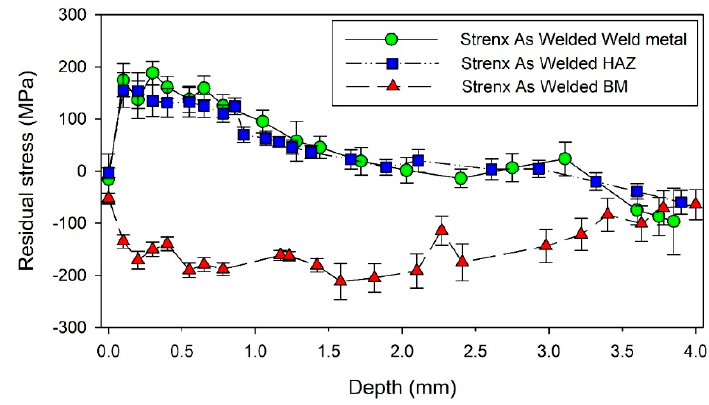
Figure 8. Residual stress in the welded joint zones prior to machining, measured at φ = 0° (axial residual stresses).